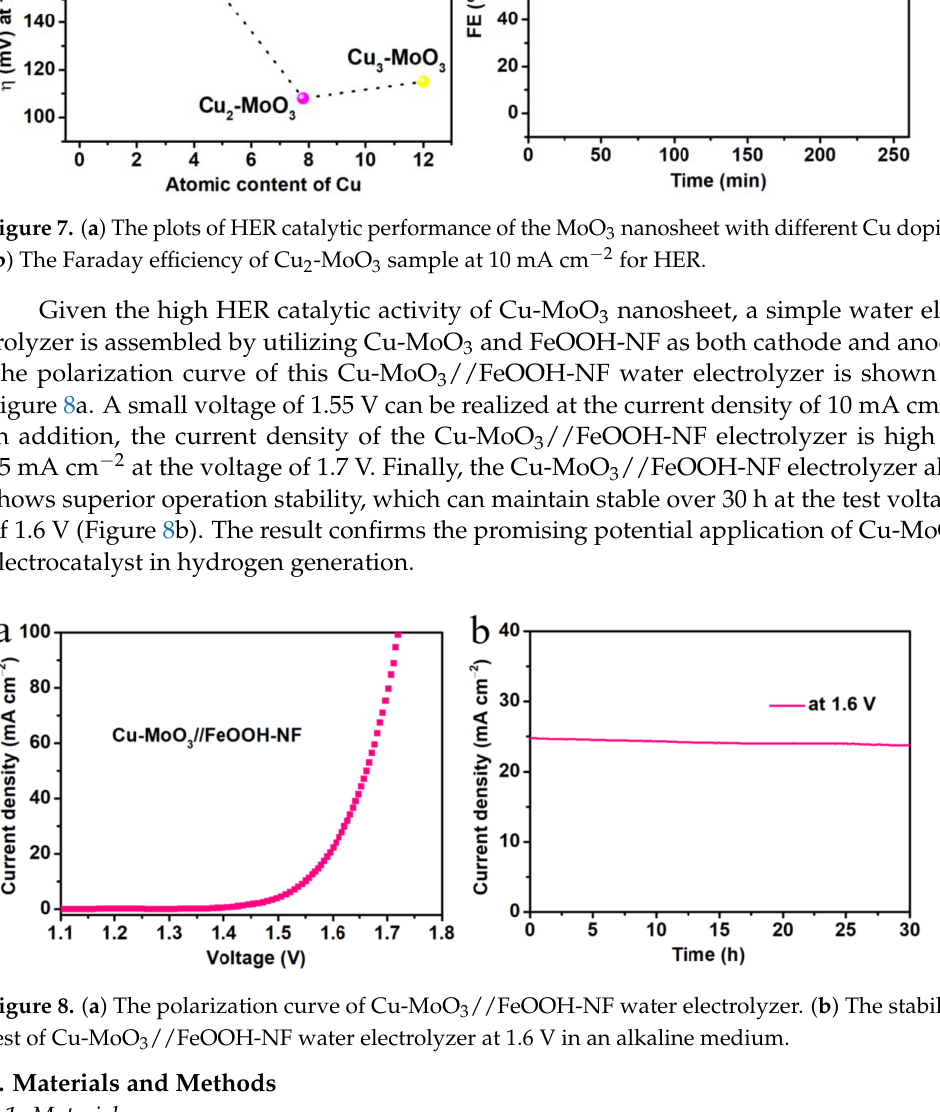
6 of 10 Figure 6. ( a ) The EIS spectra, inset: image of equivalent circuit model, ( b ) double-layer capacitance plots of Cu foam, MoO 3 and Cu-MoO 3 , ( c ) C dl normalized performance and ( d ) the performance comparison of MoO 3 and Cu-MoO 3 samples. To analyze the effect of Cu doping on improving the HER catalytic performance, the MoO 3 nanosheet with various contents of Cu is synthesized by regulating the usage of the Cu source. As shown in Figure 7a and Figure S6, the contents of Cu are measured by the ICP method, which are 3.2 %, 7.8 % and 12.0 % for Cu 1 -MoO 3 , Cu 2 -MoO 3, and Cu 3 -MoO 3 samples, respectively. Moreover, the HER catalytic activity of all prepared samples is tested in 1 M KOH solution. The catalytic activity increase from pristine MoO 3 sample to Cu 2 -MoO 3 nanosheet, and then decrease to Cu 3 -MoO 3 sample. We speculate that in Cu- doped MoO 3 electrocatalysts, the electronic conductivity and catalytically active sites are two competing relationships. When the doping amount of Cu is low, the electronic con- ductivity of MoO 3 material is not significantly improved, so the improvement of catalytic activity is insufficient. When the amount of Cu doping is too high, more Cu sites cover the surface of the MoO 3 catalyst to hinder the Mo catalytic active centers, resulting in a de- crease in catalytic performance for HER. Therefore, those results indicate the optimal dop-